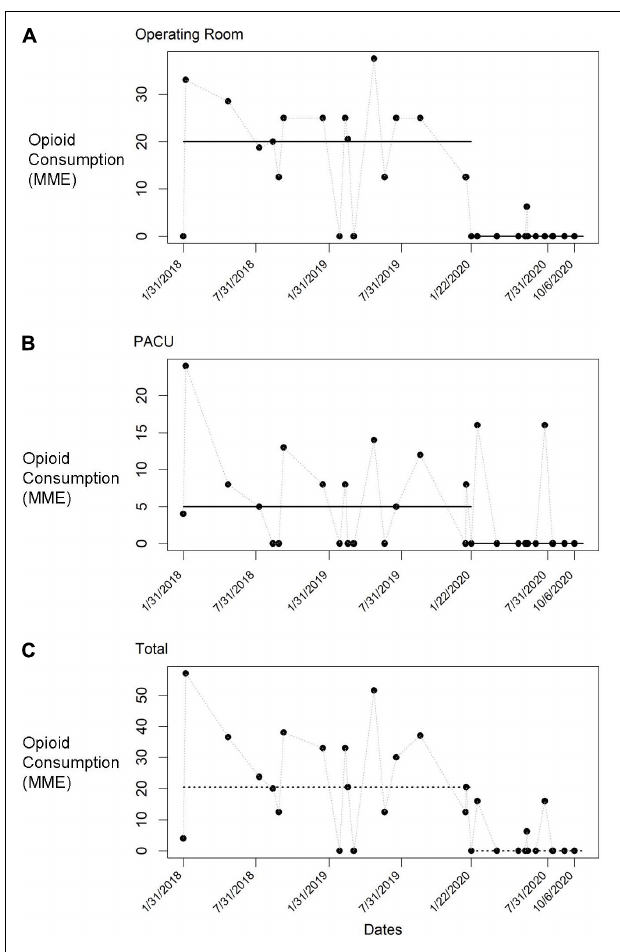
Prior to implementation, median (IQR; min-max) ( n = 19)